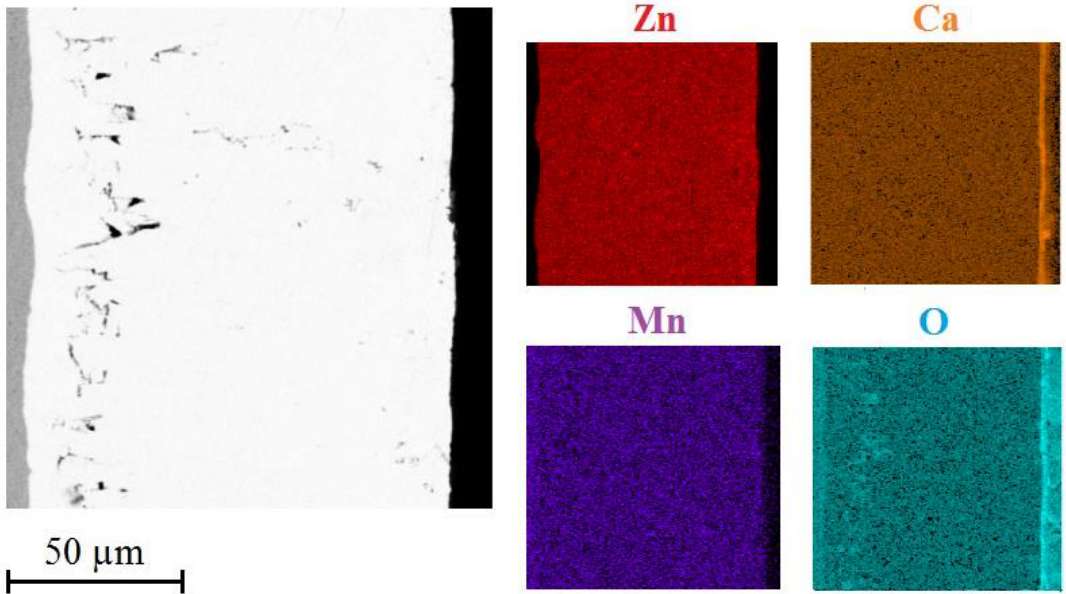
Figure 20. Morphology of precipitated corrosion products on the surface of HDG sample after ex- posure (3 months) in simulated concrete pore solution of pH 12.8 with addition of KMnO 4 − (solution Mn (2) ).